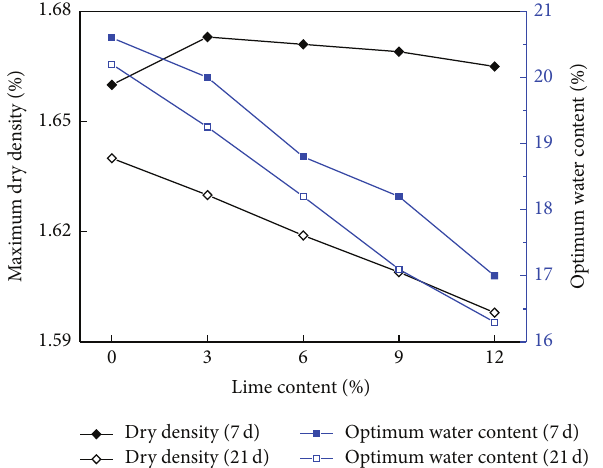
Figure 2: Variation of lime contents with maximum dry density and optimum moisture content under different curing periods.